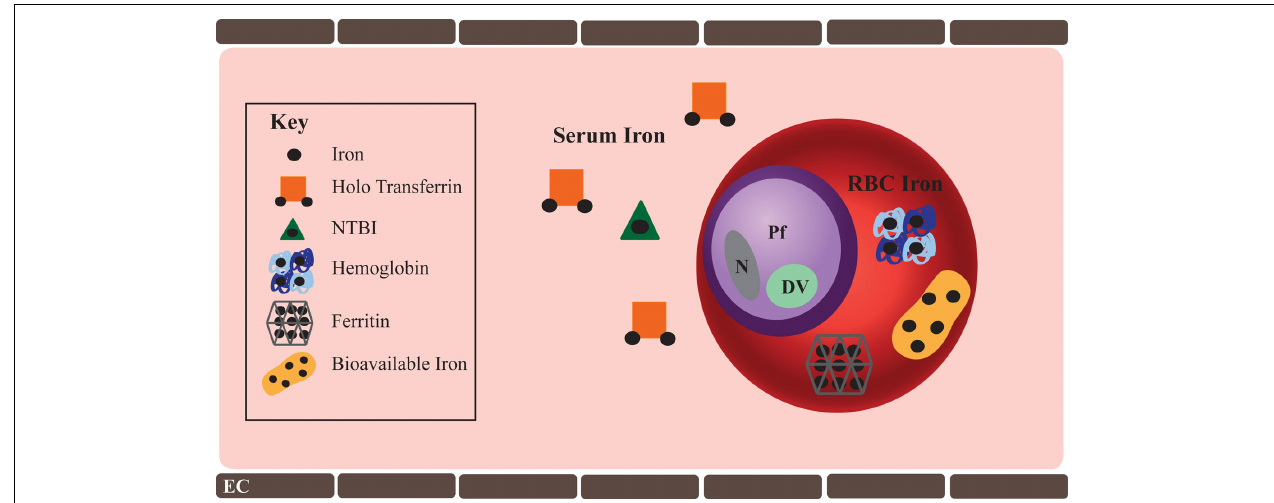
FIGURE 1 | Host Iron available to erythrocytic stage P. falciparum . Host iron immediately available to the erythrocytic stage of P. falciparum include serum and intra-erythrocytic iron. Serum iron ranges from 10 to 27 μ M. Transferrin bound iron is the predominant form of iron in the serum, though trace amounts of non-transferrin bound iron (NTBI) are present. In some pathologic conditions such as hemochromatosis, NTBI may be